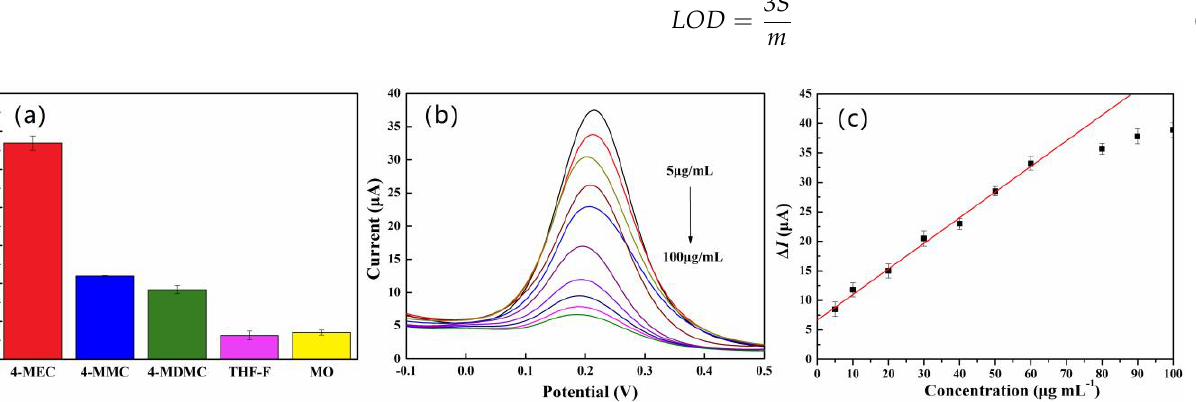
Figure 8. Selectivity of GO-MIPs/GCE toward different interferents ( a ), DPV responses of GO-MIPs/GCE for various concentrations of 4-MEC ( b ), and dependence of Δ I on the concentration of 4-MEC ( c ) in a solution containing 5.0 mmol L − 1 of K 3 [Fe(CN) 6 ] and 0.1 mol L − 1 KCl.